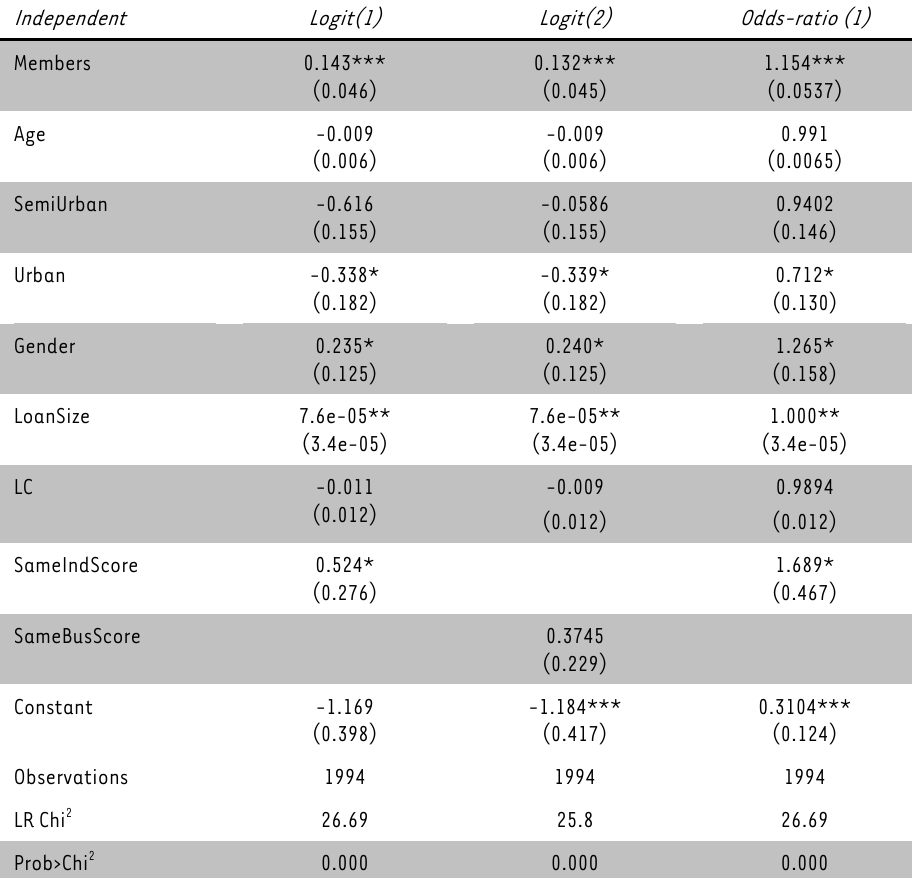
TABLE 5: Marang Logit Regression Results: Dependent variable